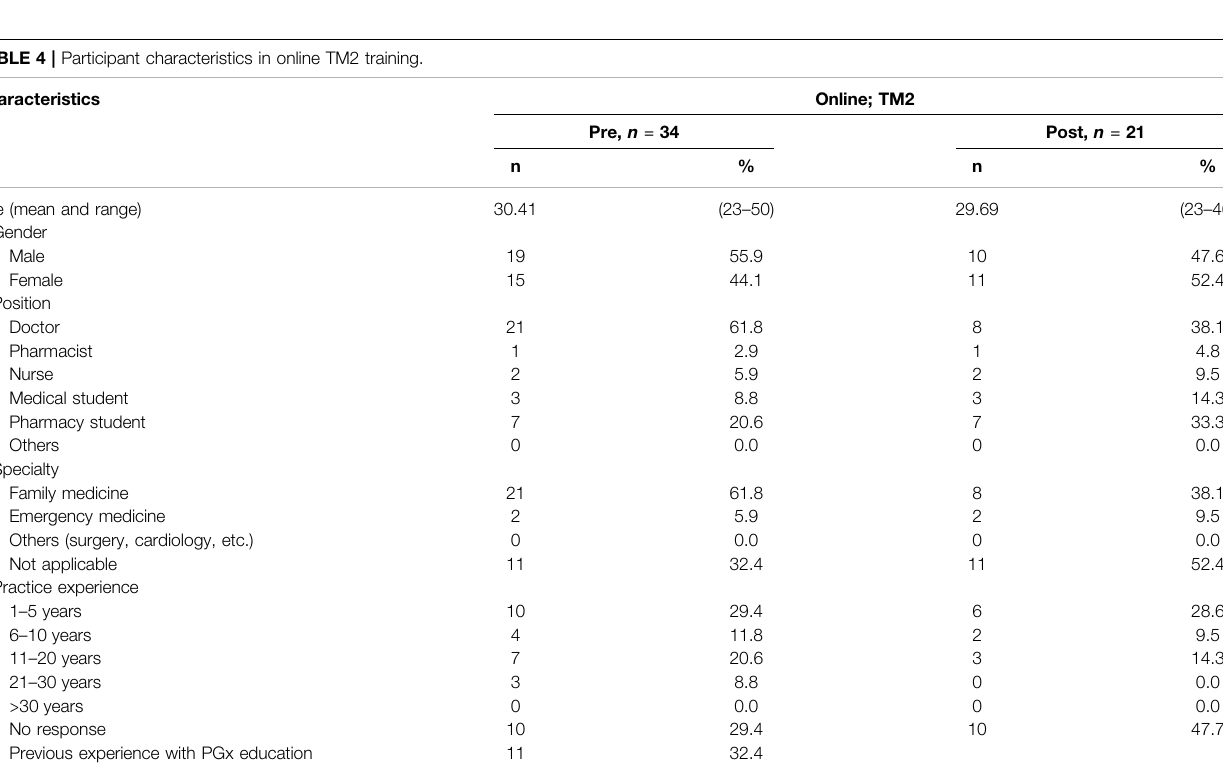
FIGURE 4 | Numberofresponses fromfocus group discussion feedback. TM1 participantshighlysuggested more casestudies tobe added on the training material.